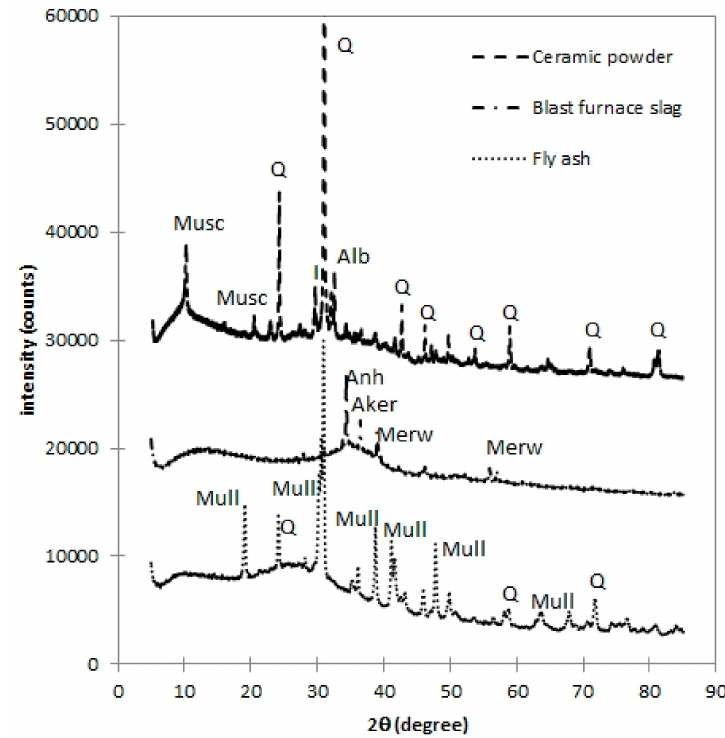
Figure 1. X-ray di ff ractograms of studied mineral additives (Q = quartz; Musc = muscovite; I = illite;